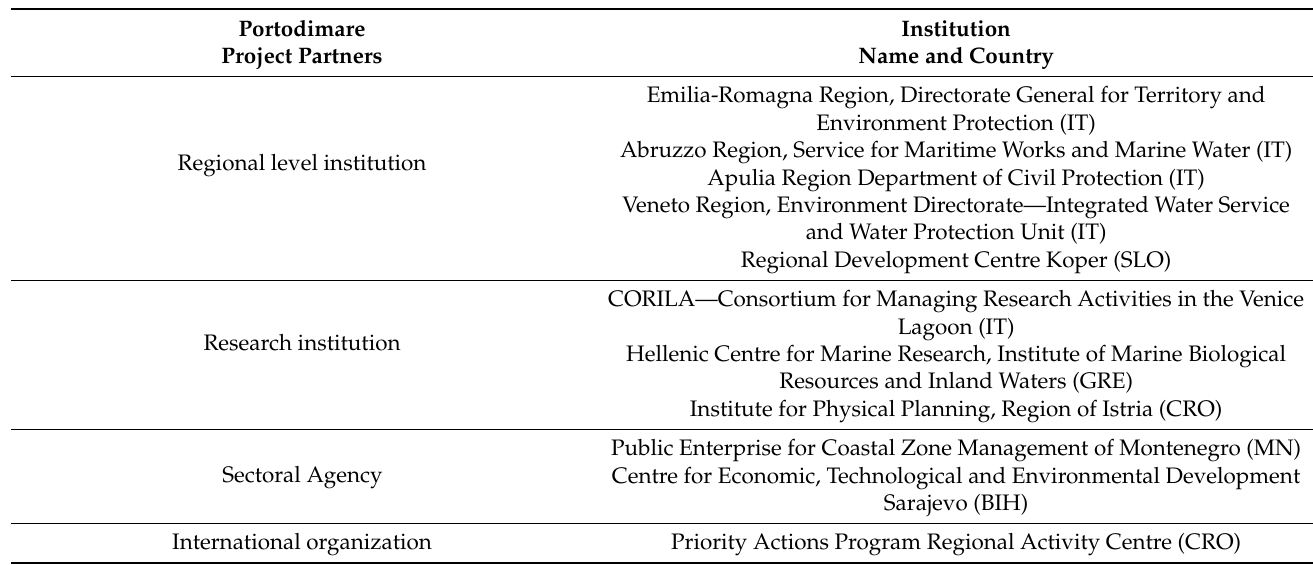
Table 12. List of participating institutions in the case of the PORTODIMARE